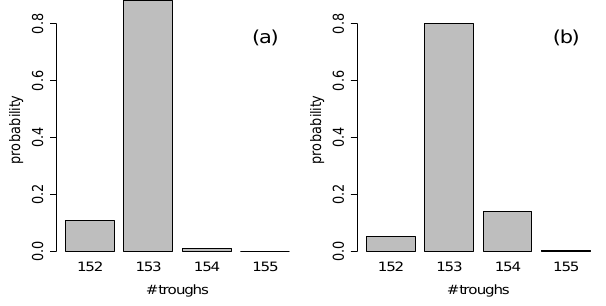
Fig. 7. The effect of the number of sections β used in the initial Fig. 6. Bar plots showing the probability distributions of the number smoothing of the H 2 O 2 signal, and the threshold ν for classify- of annual troughs – a summary of the chronology – in the dating of ing individual points, on the probability distribution obtained for the Gomez core, based on two possible values of the threshold ν for the number of annual troughs – a summary of the chronology – in classifying individual points, and dividing the core into β = 6 sub- the dating of the Gomez core. Each circle has area proportional to sections for the initial smoothing process. (a) Threshold ν = 0 . 5. the probability of a particular number of troughs, when the recon- √ (b) Threshold ν = 1 / 2. struction uses particular values of β and ν . (a) ν = 0 . 3 ,..., 0 . 8 with √ β = 6. (b) β = 2 ,..., 20 with ν = 1 /